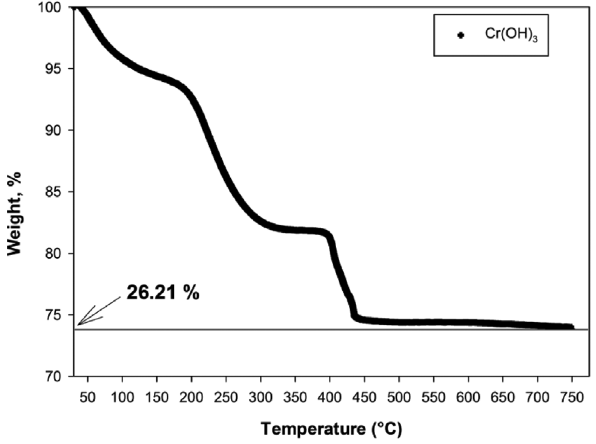
Fig. 12: TGA plot of conversion of the Cr(OH) 3 into Cr 2 O 3